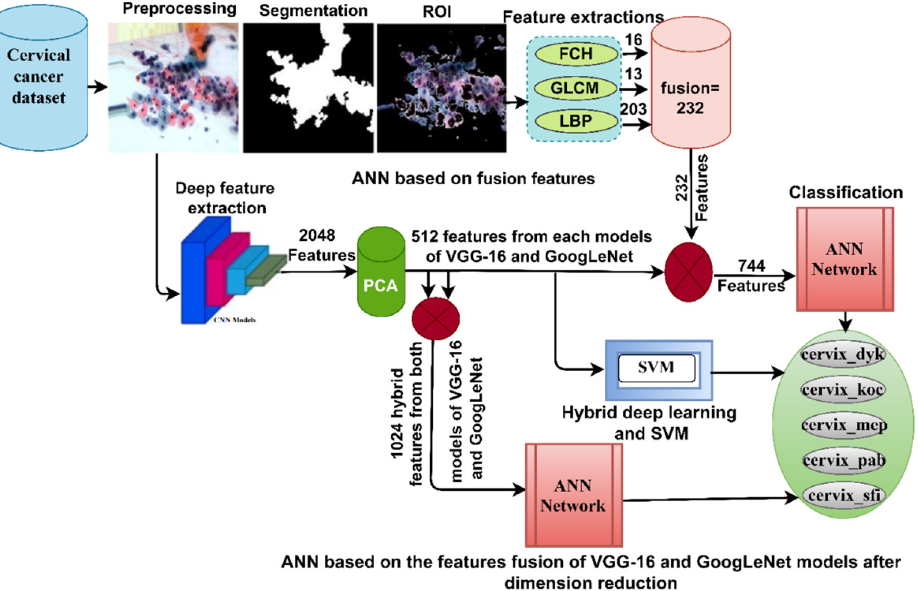
Figure 1. Structure framework for proposed approaches to the diagnosis of WSIs for the cervical cancer data set.